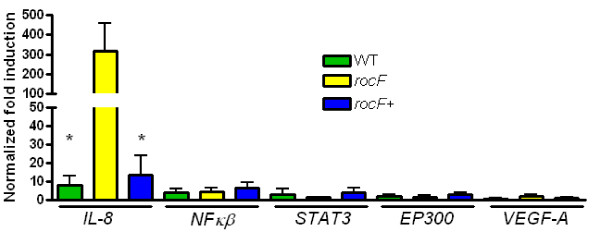
Infection with theH. pylori26695rocF-mutant induces significantly higher levels ofIL-8than its wild type orrocF+counterparts. Fold induction of genes depicted in Figure 2, performed as explained in Materials and Methods using GAPDH as housekeeping gene and one internal calibrator. * p < 0.0001, as compared to the induction in response to the infection with H. pylori rocF-. Values represent the average expression ± SEM of three independent replicates.